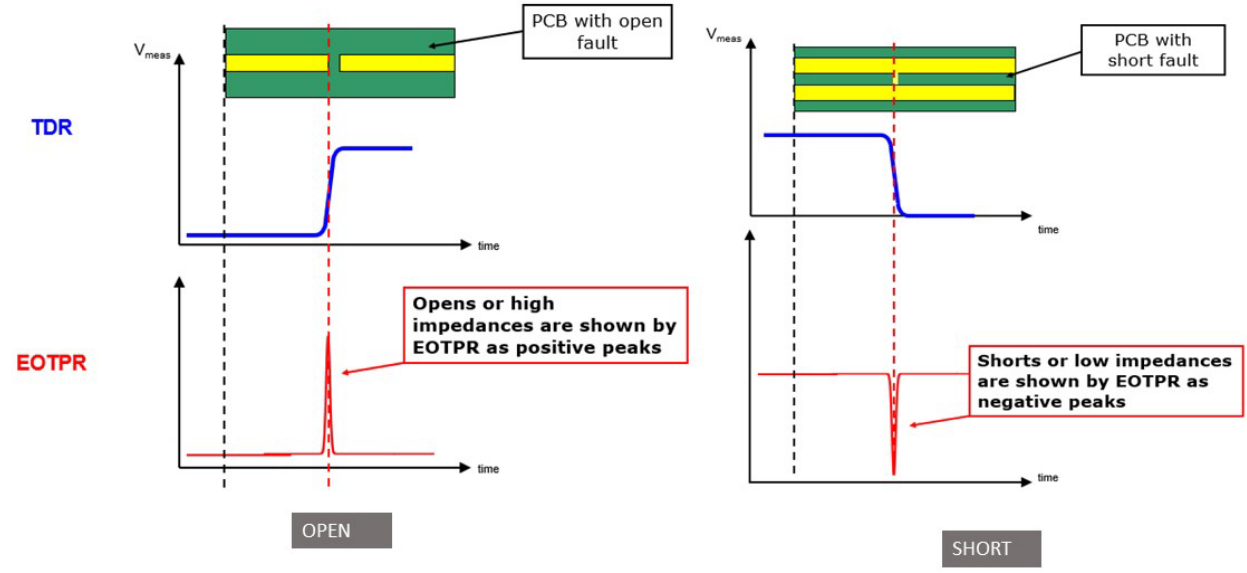
Figure 6. Terahertz EOTPR compared to microwave TDR for fault isolation.